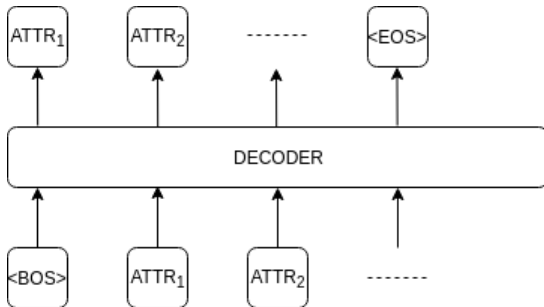
Figure 3. Input format of the sequential